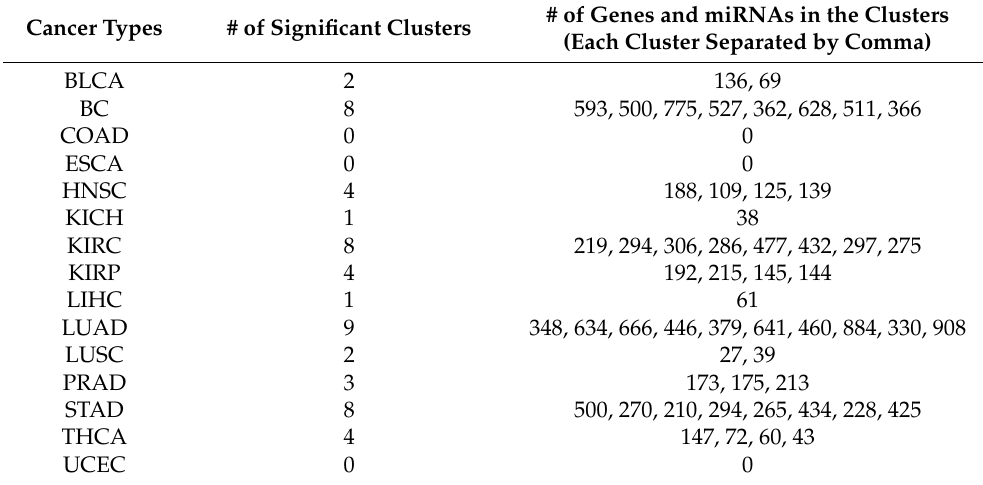
Table 1. Information of significant clusters for 15 The Cancer Genome Atlas (TCGA) cancer types. Cancer